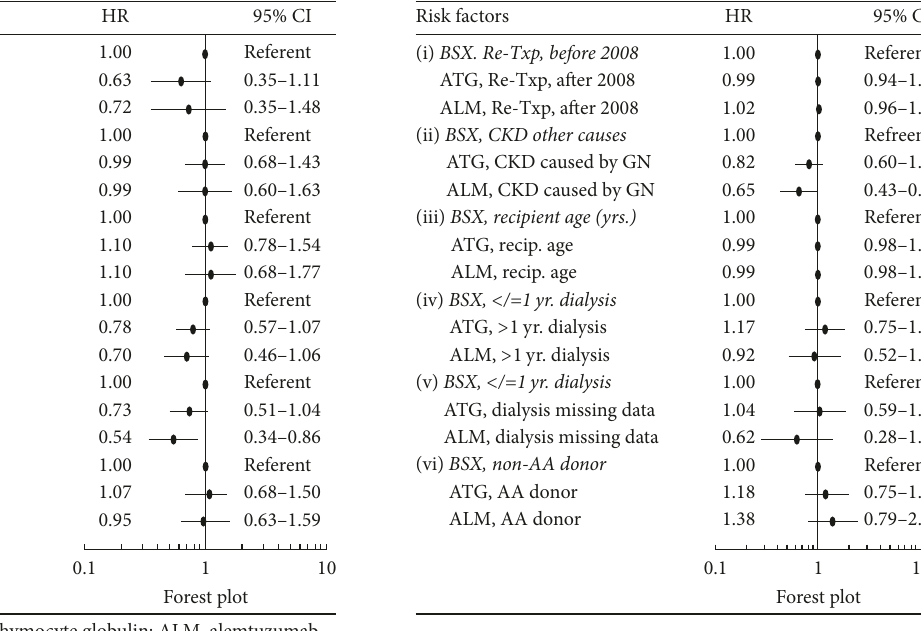
Figure 6: Death-censored retransplant loss in 5 years, Cox model with